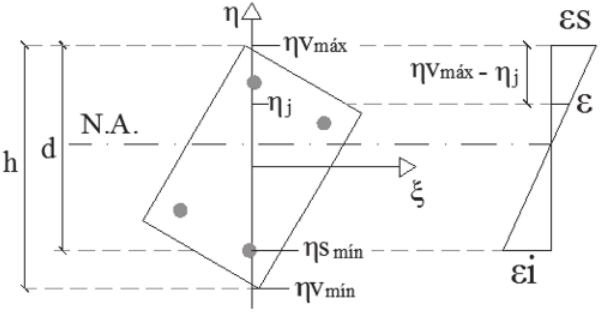
Figura 5 Altura total e altura útil da seção